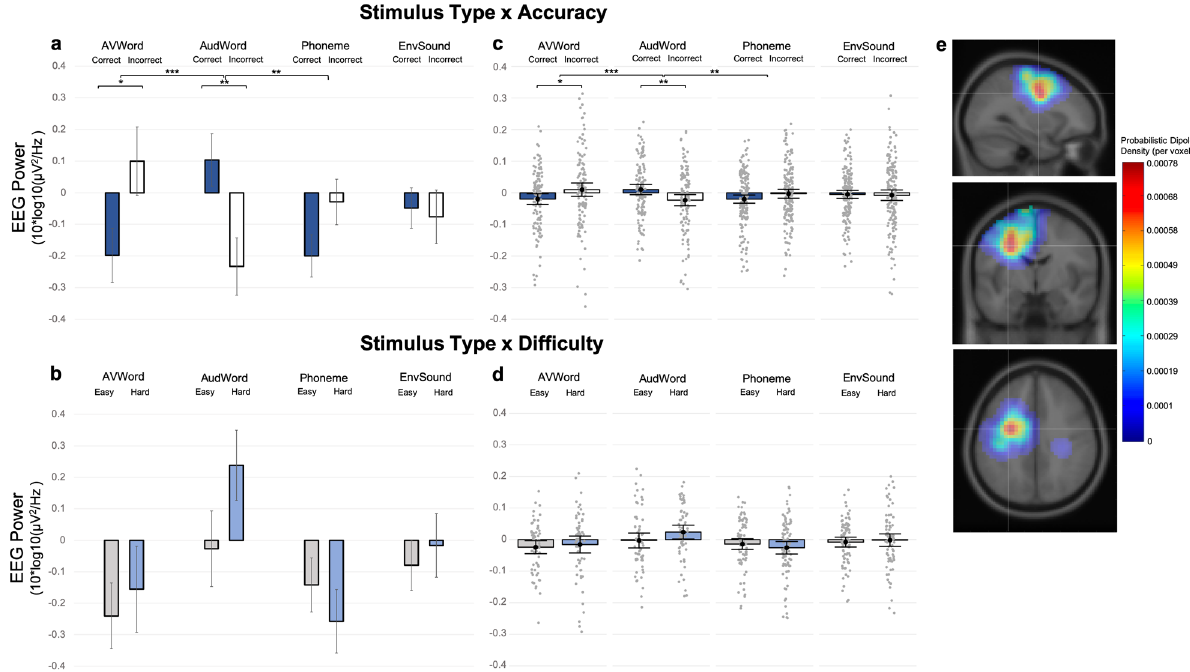
Fig. 7 EEG activity in the left sensorimotor cluster. Mean EEG power (10 × log10( µ V 2 /Hz) for a stimulus type and accuracy and b stimulus type and dif fi culty level. Plots in c and d show the same mean values as a and b , but with individual data points overlaid. e Left hemisphere sensorimotor cluster location, created using EEGLAB plugin std_dipoleDensity() , with a Gaussian smoothing kernel set to FWHM = 15 mm. Error bars represent mean ± 1.96 × standard error. Signi fi cance levels: * = p < 0.05, ** = p < 0.01, *** = p < 0.001. Our analysis used a series of mixed-effects models with subject and independent component (IC) as the random effects. The n for the above plots differs by stimulus type and accuracy/dif fi culty and is given in SI Table 5. The average number of ICs per subject per condition is given in SI Table